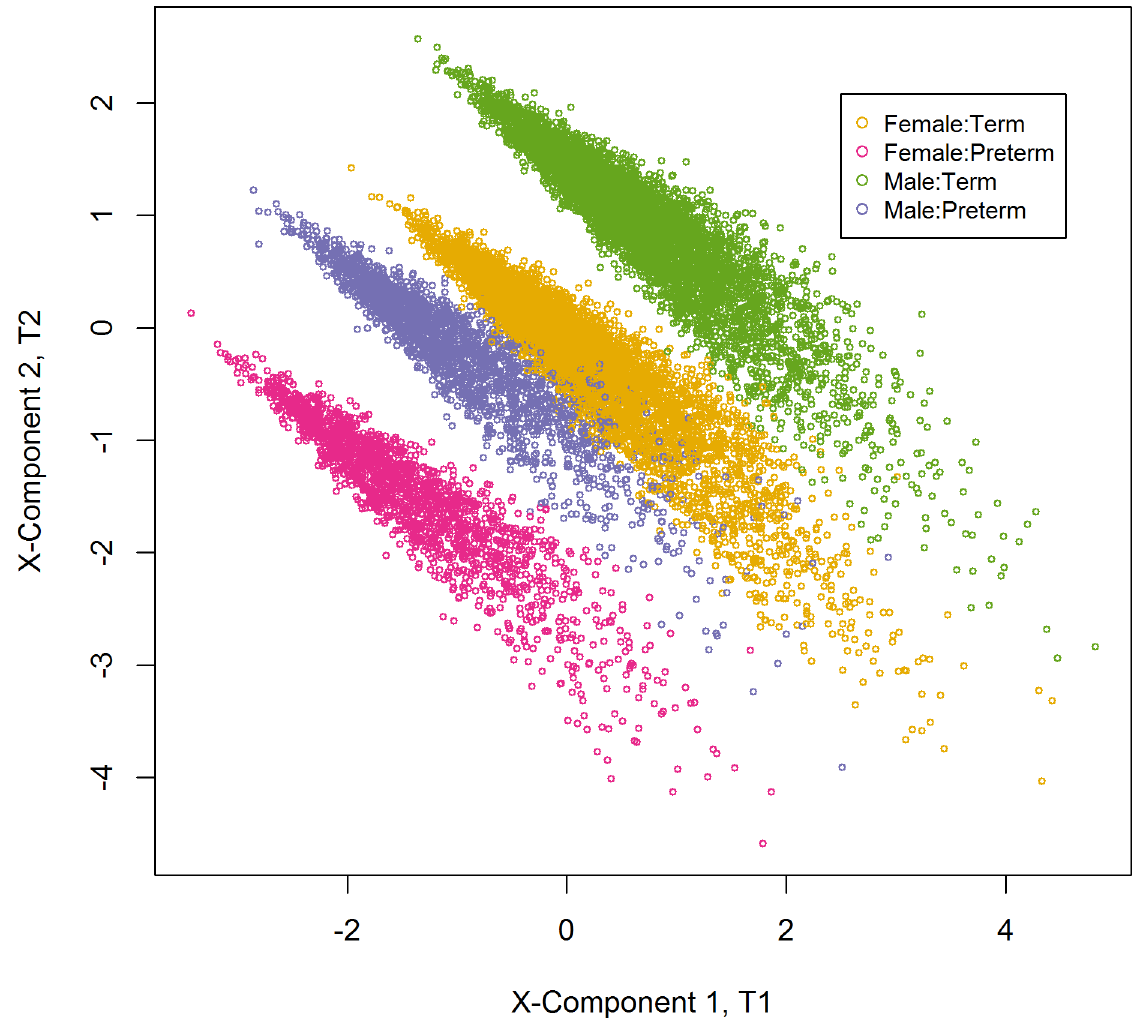
Fig 5. Scatter plot of the scores of first two PLS components of the predictors. Demonstrating 4 groups amongthe individualsparticipatedin the study due the interaction effect of infant’s sex and preterm delivery.